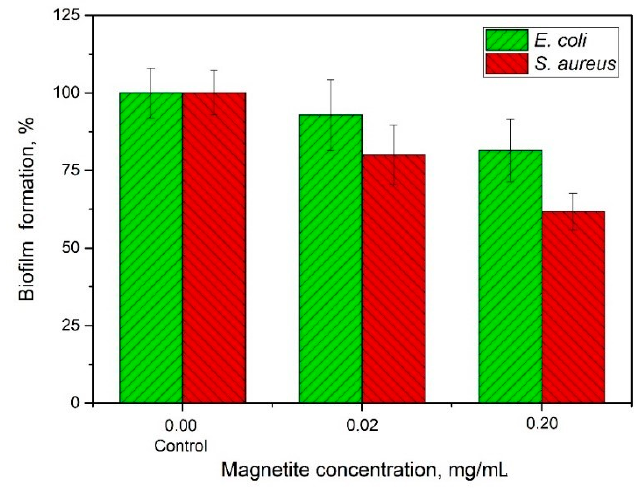
Figure 6. Efficacy of magnetite NPs against the formed biofilms: E. coli and S. aureus .